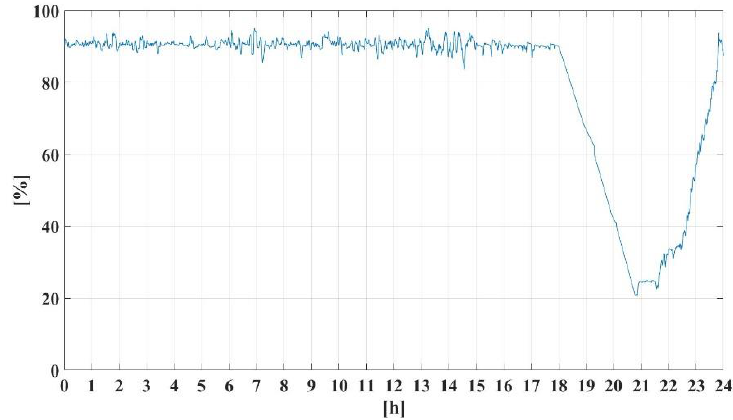
Figure 19. Field test result 3: SOC of ESS.